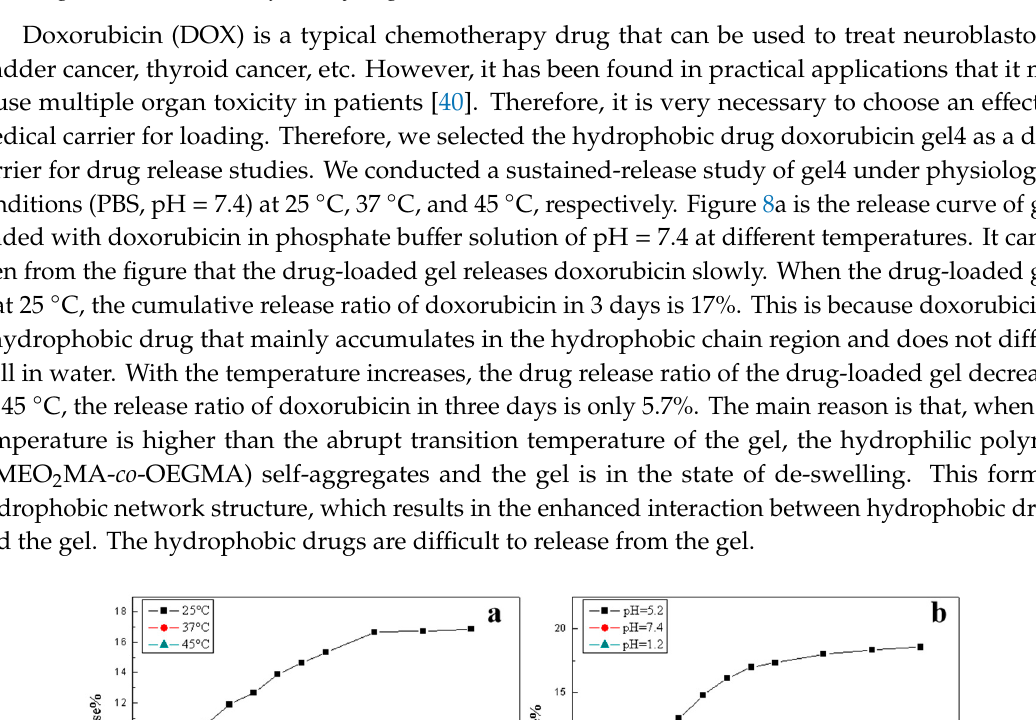
Figure 7. Variation curve of storage modulus with frequency of hydrogels .